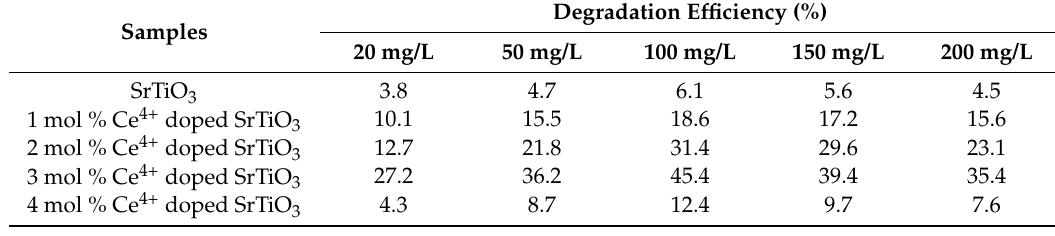
Table 5. Effect of initial concentration on photocatalytic activity.